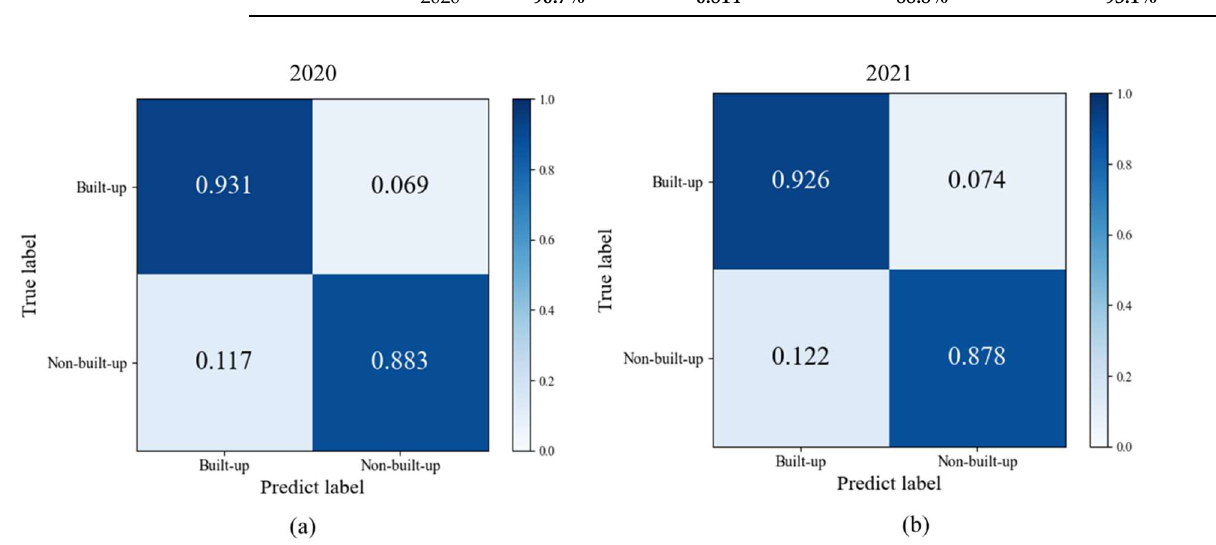
Figure 12. Confusion matrices: ( a ) 2021 Taoyuan County with our methods; ( b ) 2020 Taoyuan County with our methods.